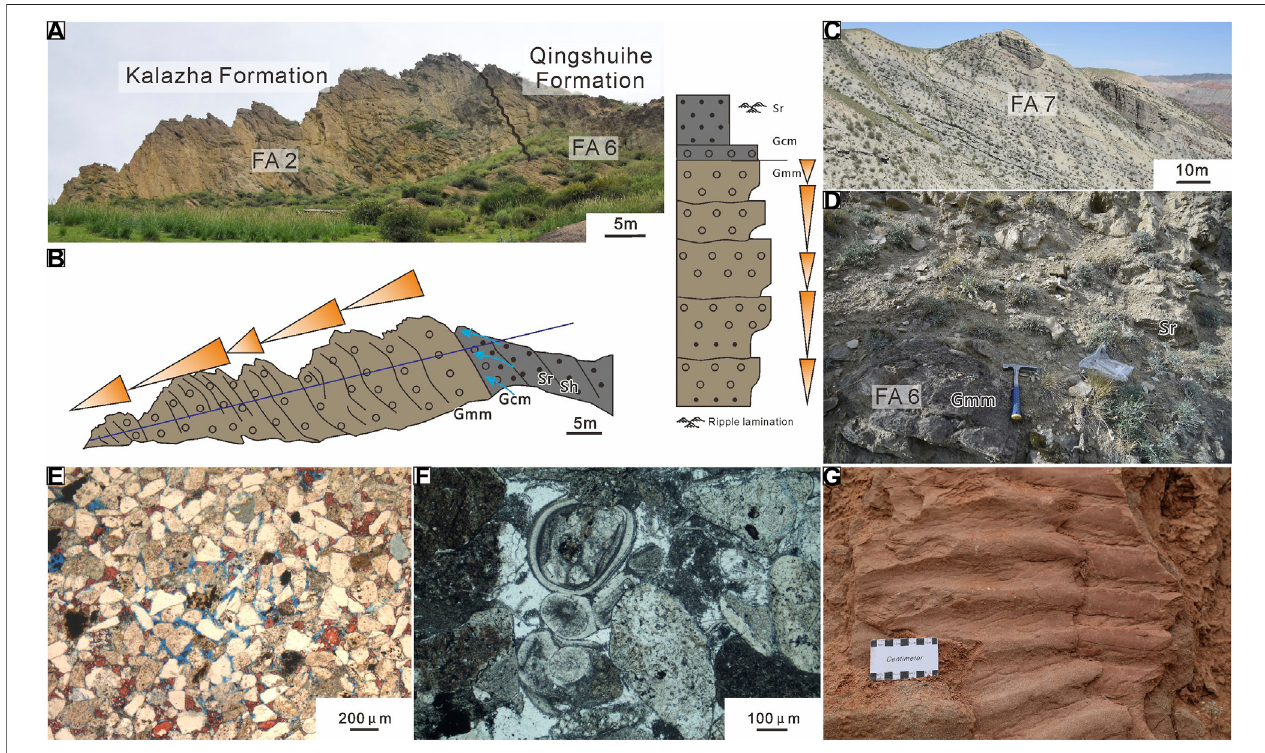
FIGURE7| SedimentarycharacteristicsoftheQingshuiheFormationintheSouthernJunggarBasin (A – D) Jiangongminesection(Guanetal.,2020).Thehammer (27.9 cm) for scale in d; (E) casting thin section withAlizarin red S, plane-polarized light, Manasi section. TheAlizarin red S stained the calcite red; (F) thin section, plane- polarized light, Dongwoz section; (G) wave ripples, Sikeshu River section. The ruler for scale. FA-facies association. The de fi nition of facies associations see Table 2 .